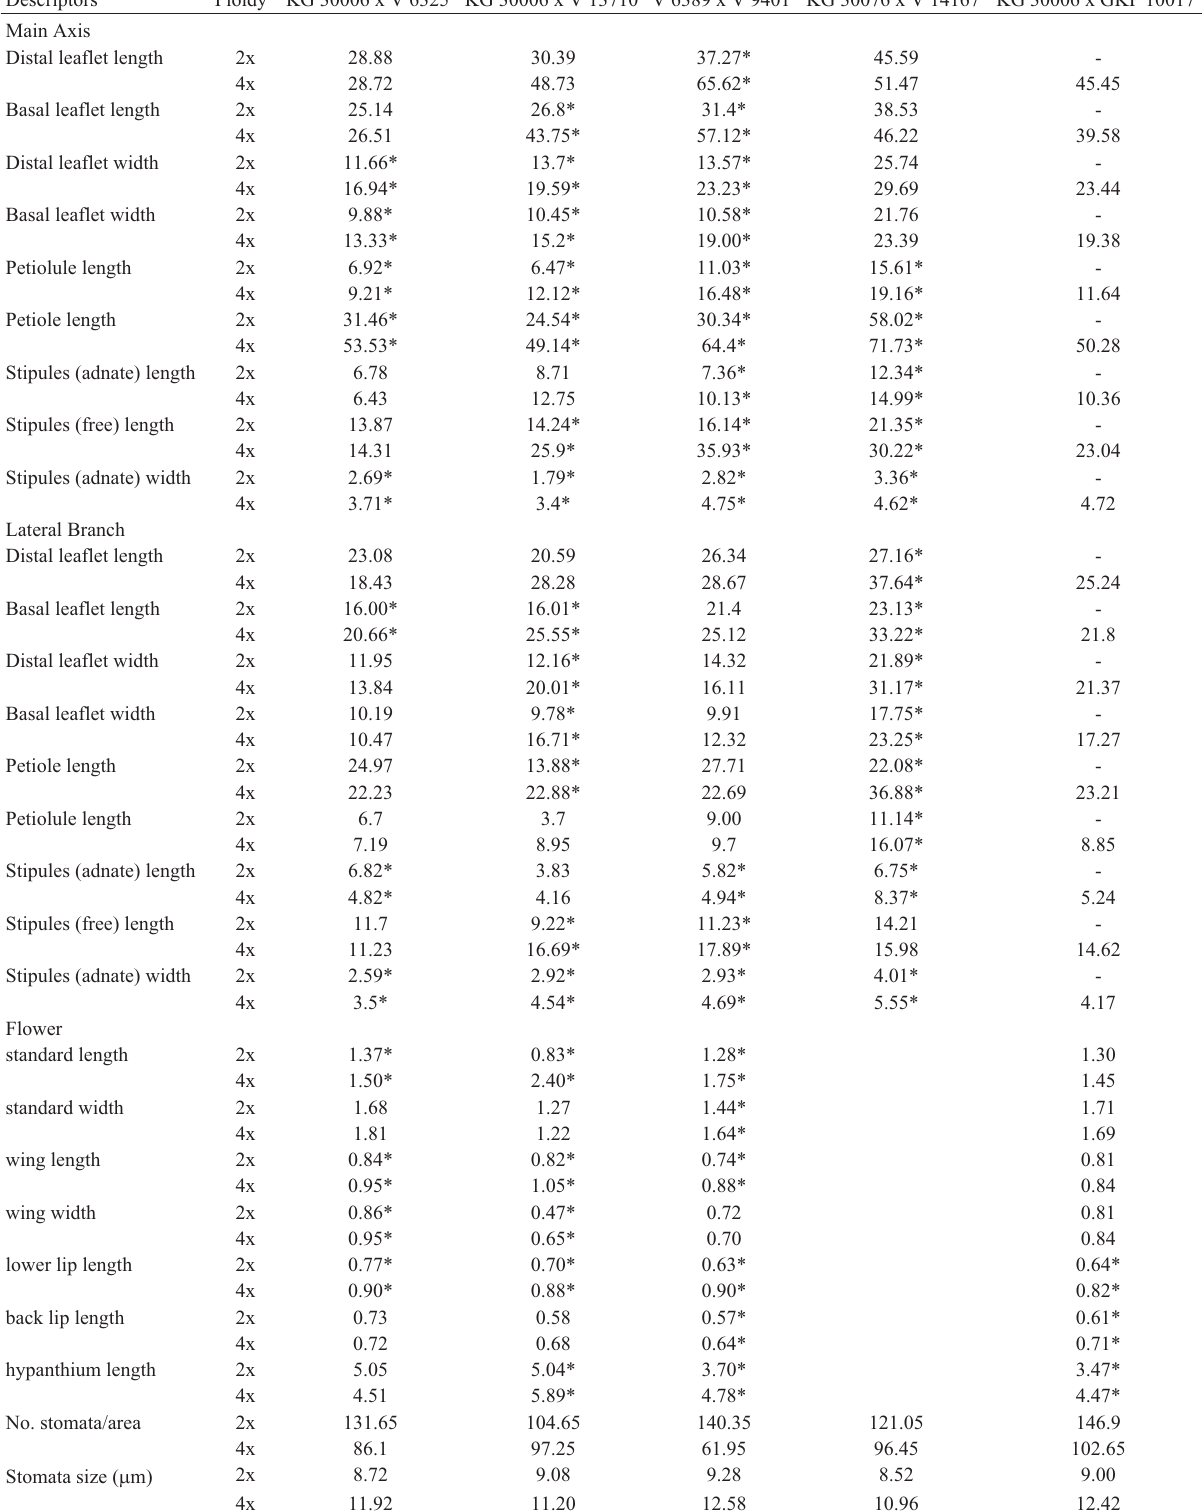
Table 2 - Morphological descriptors on the main axis, lateral branch, and flowers and stomata size under diploid (2x) and tetraploid (4x) conditions (in